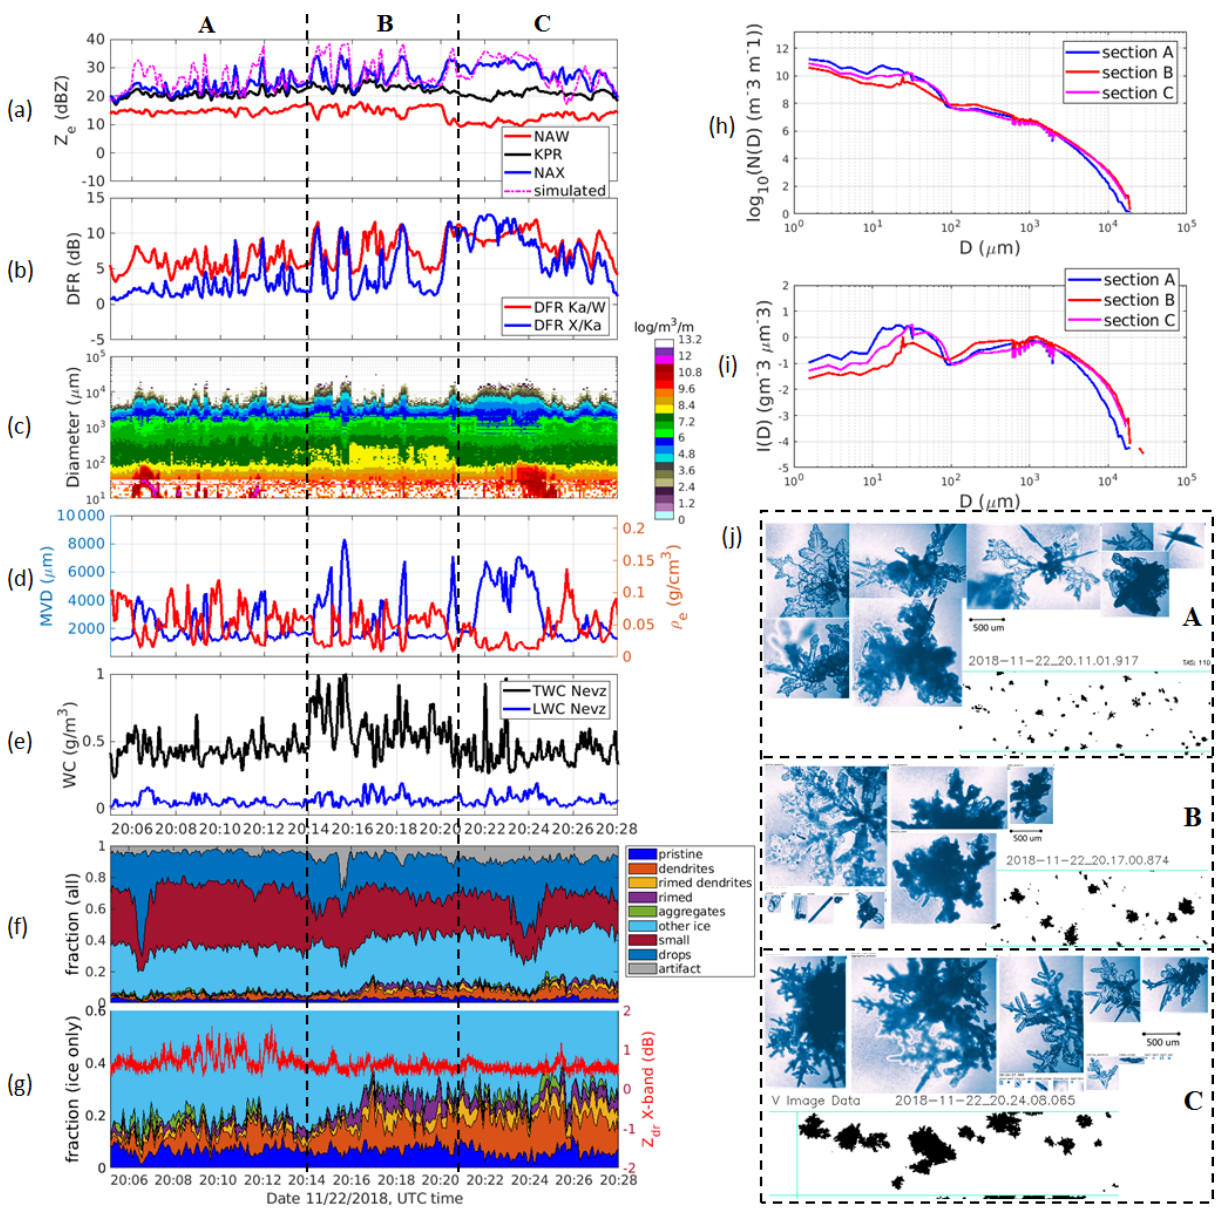
Figure 12. Similar to Fig. 10 but for flight segment 20:05–20:28UTC.